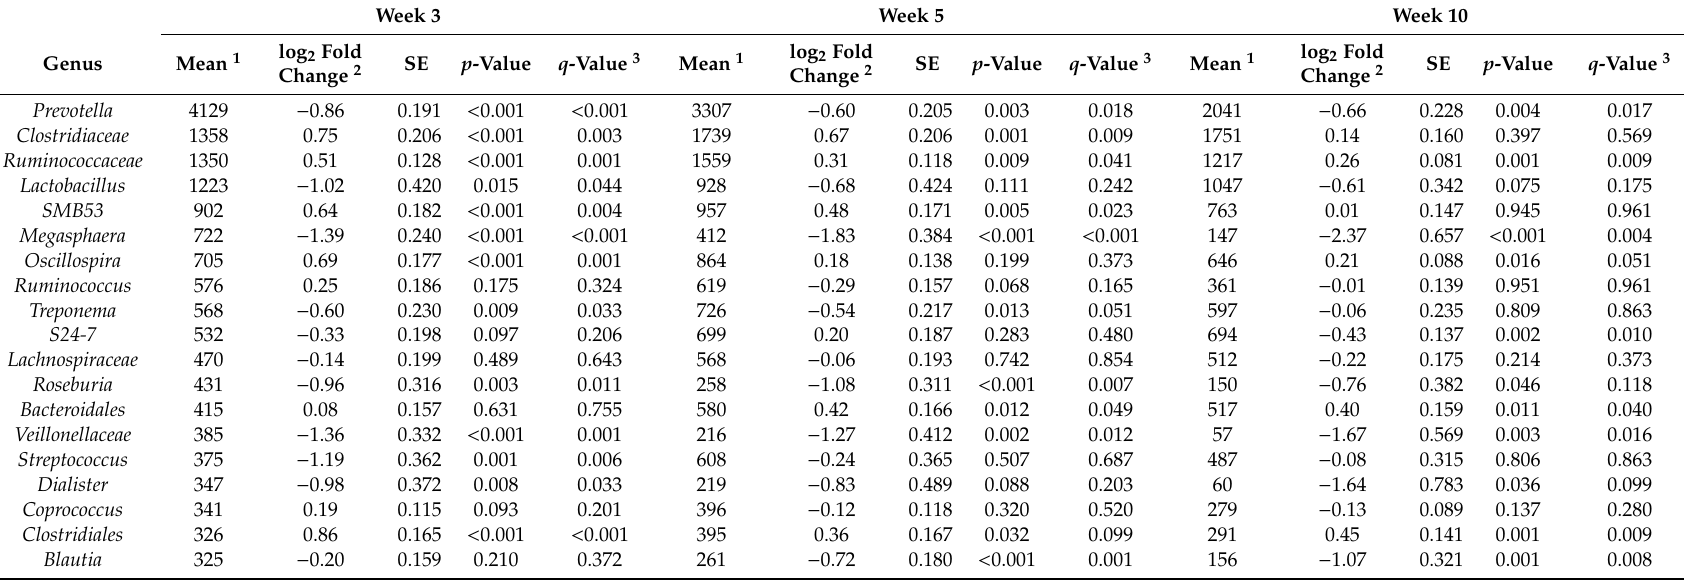
Table 5. Di ff erentially abundant bacterial genera in feces of pigs fed diets with or without phytase supplementation over